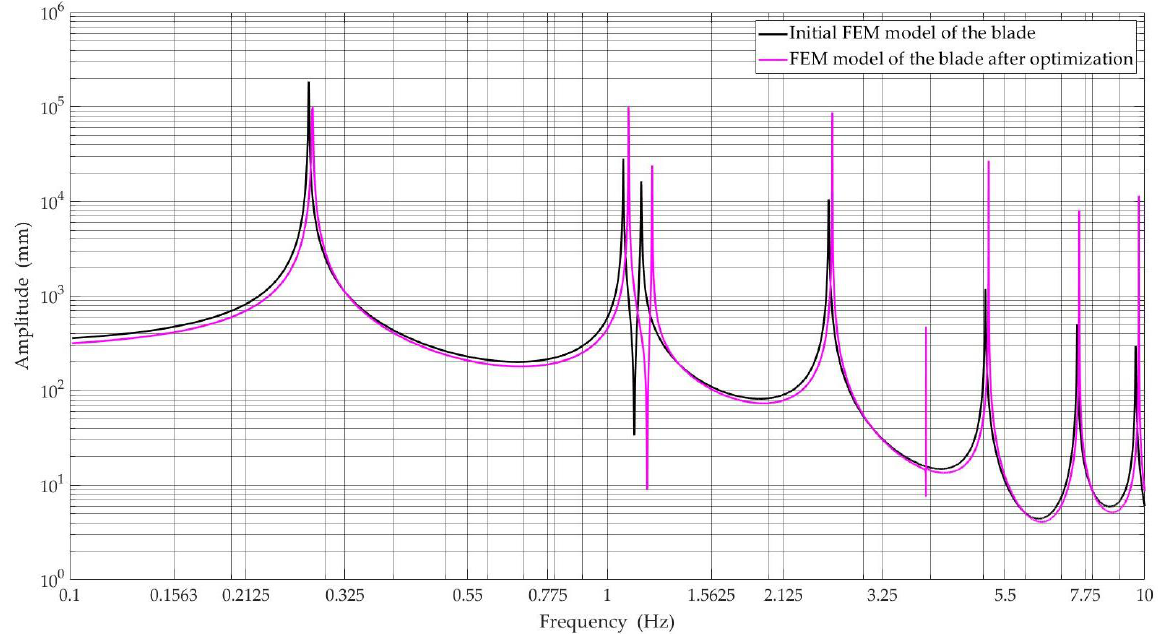
Figure 9. Amplitude-frequency characteristics were determined in the node located in the middle of the blade span for the initial FEM model and FEM model after optimization.